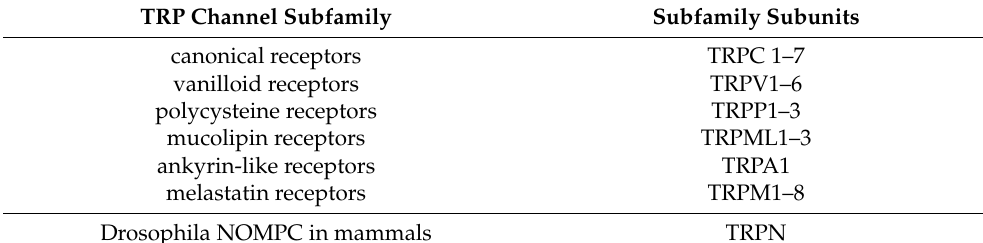
Table 1. TRP channel superfamily.